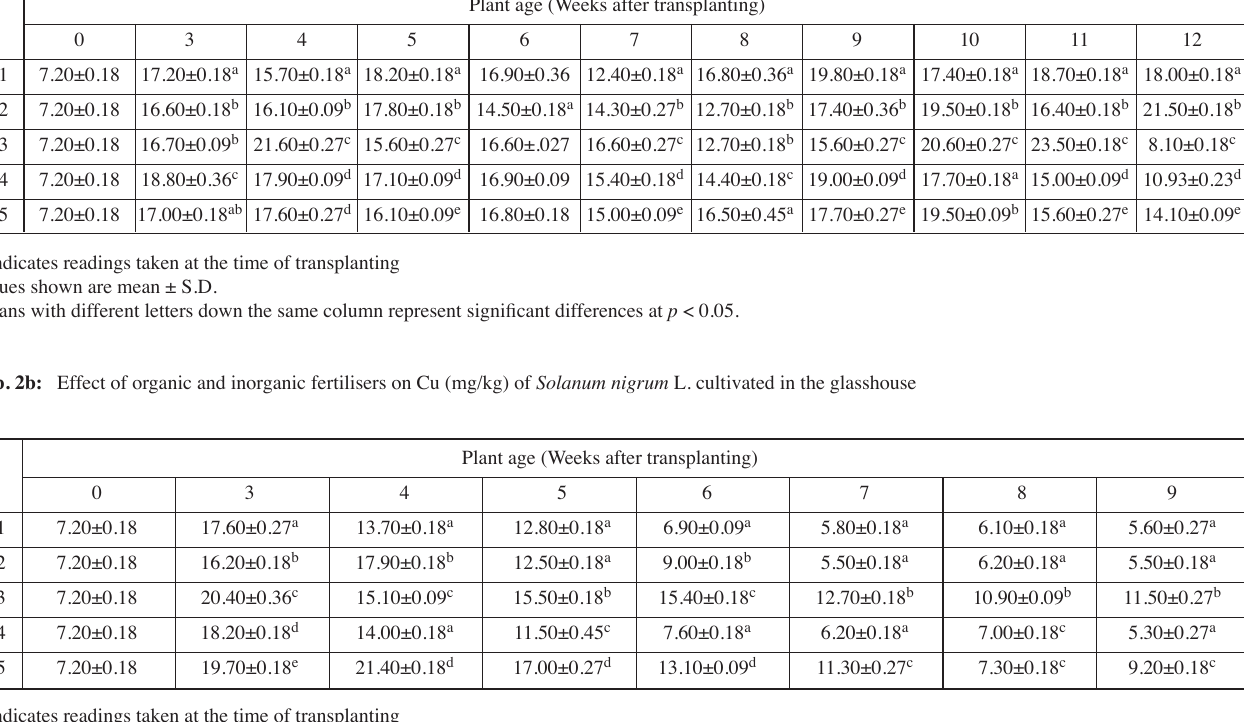
Plant age (Weeks after transplanting)